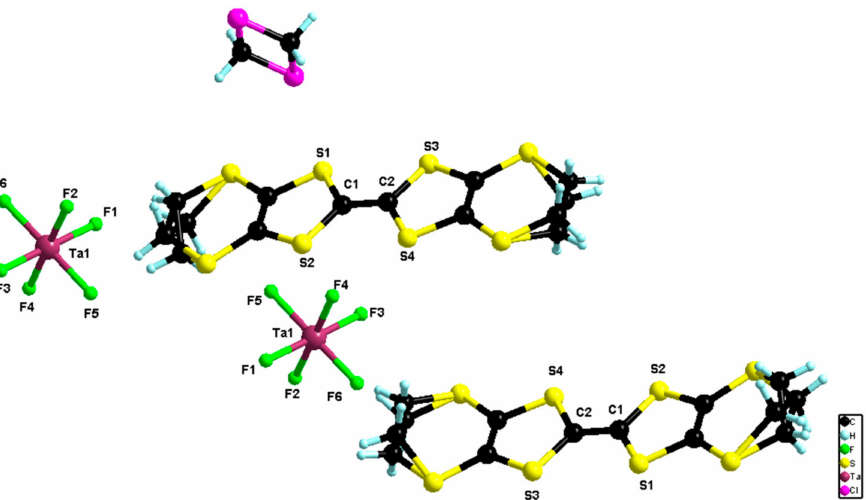
Figure 8. Molecular structure of (BEDT-TTF) 2 (TaF 6 ) 2 · CH 2 Cl 2 . The two carbon atoms of the two ethylene parts were disordered over two positions with refined partial occupancy factors (0.62/0.38 and